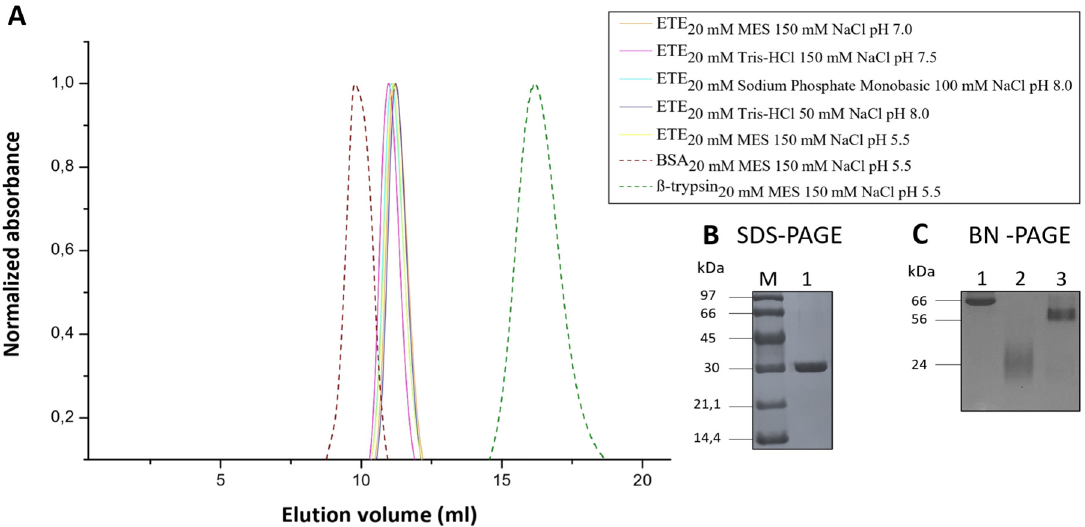
Figure 4. ETE is a dimer in different solution conditions. ( A ) SEC profiles for ETE under different buffering conditions (solid line). BSA and β -trypsin were employed as controls (dash line). Absorbance was measured at 230 nm in all cases, and normalized values are plotted. The overlap of peaks at ~12 mL indicates that ETE elutes in the same oligomeric state in all the tested conditions. ( B ) SDS-PAGE of ETE (1) using the protein marker LMW-SDS Marker KIT—GE Healthcare (M). ( C ) BN-PAGE of ETE (3) using BSA (1) and β -trypsin from bovine pancreas (2) as molecular weight markers. A running buffer containing 25 mM Tris pH 8.3 and 192 mM Glycine was employed for BN-PAGE.